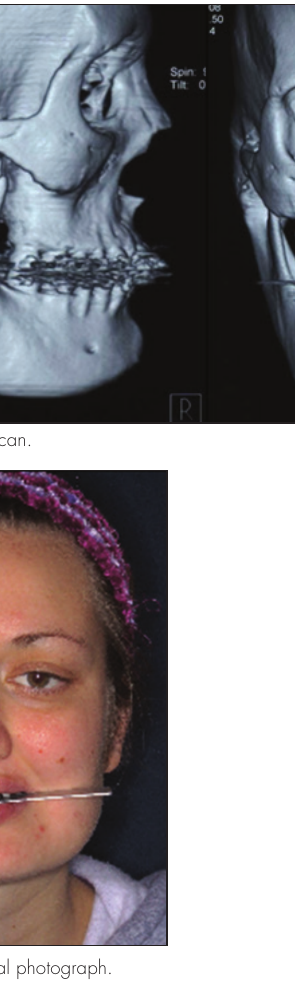
Figure 1c. Pretreatment cephalograms.